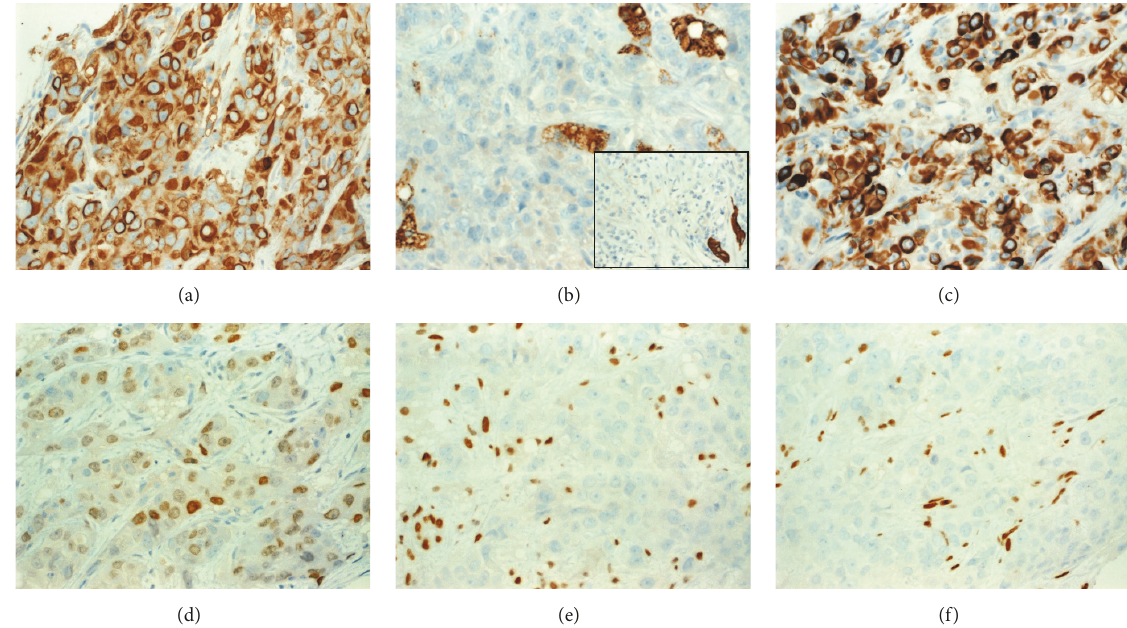
Figure 3: By immunohistochemistry, the neoplastic cells expressed strongly pancytokeratin with frequent paranuclear accentuation in the rhabdoid inclusions (a). The neoplastic cells were negative with HepPar-1 ((b) main image; see strongly stained hepatocytes) and CK7 ((b), inset; residual biliary tract epithelial cells are strongly stained). (c) CK20 was expressed in most of cells. (d) GATA3 was focally positive. Both of SMARCA4 (e) and SMARCA2 (f) are lost in the tumor cells (endothelial cells are strongly positive for both markers as internal